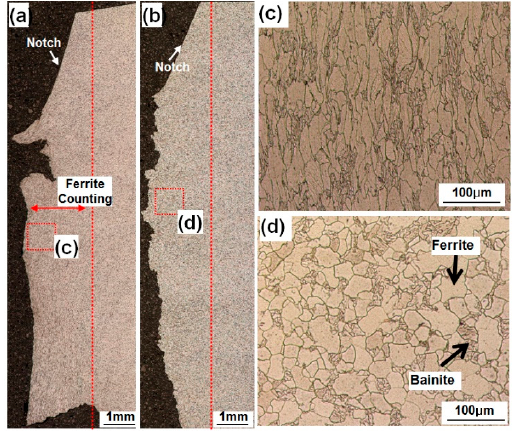
Figure 8. Microstructure of the base metal: ( a ) 386J specimen and ( c ) is ( a ) part enclosed with a red square; ( b ) 21 specimen and ( d ) is ( a ) part enclosed with a red square.